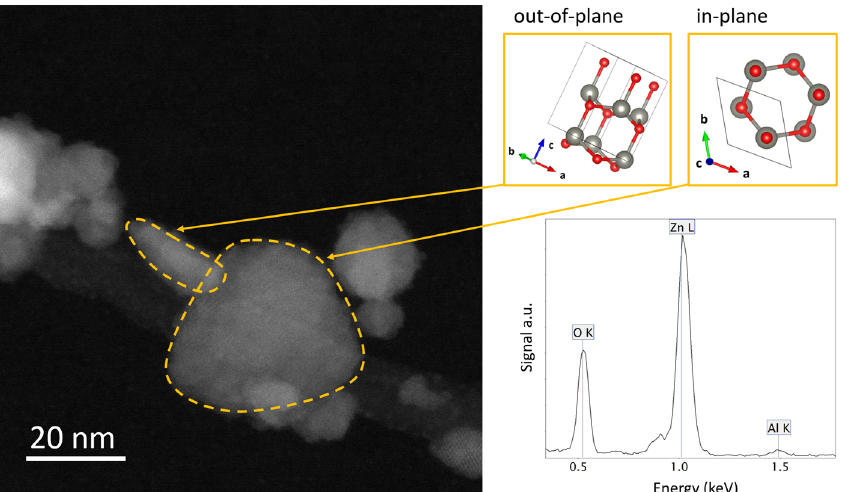
Figure 3. STEM Z-contrast image of an AZO-decorated CNT portion showing AZO–NPs with or- thogonal orientations indicated by the atomic models on the upper-right panel. On the bottom right panel, an EDX spectrum of the AZO–NPs.